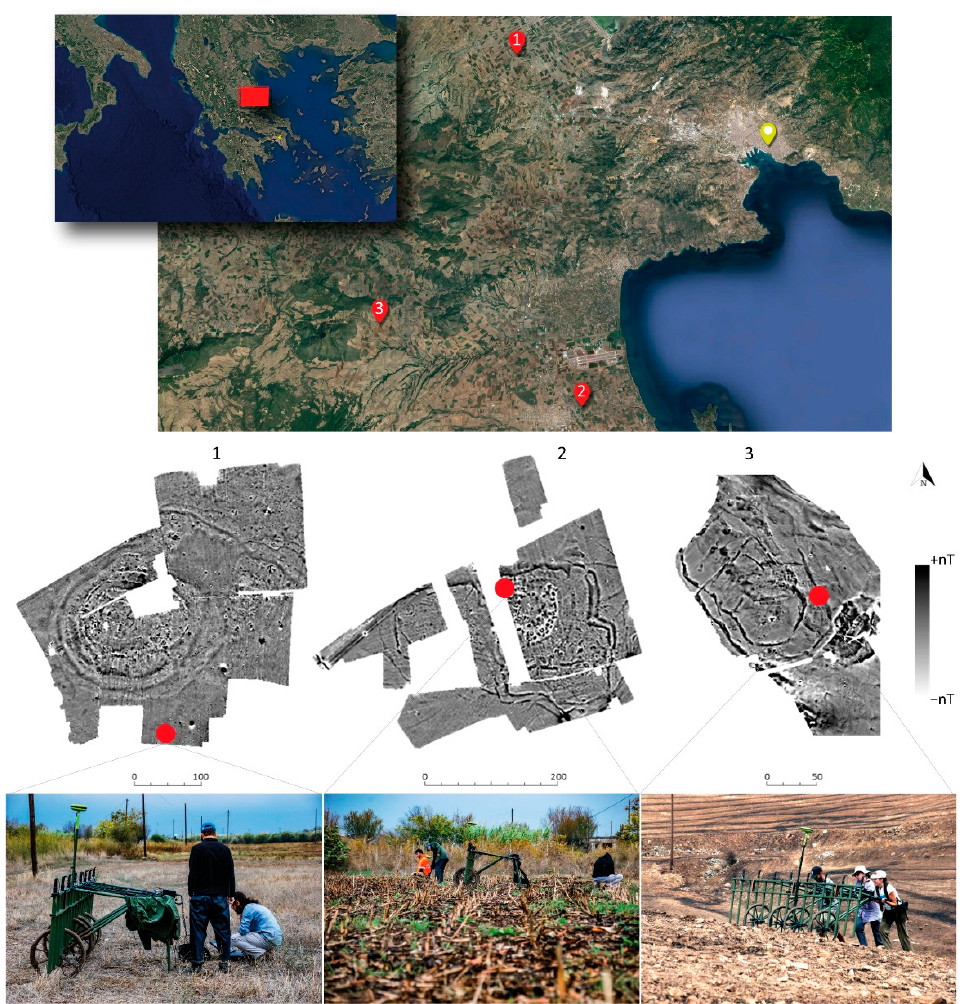
Figure 1. General location of the three case studies in the Thessalian plain ( top ). The red pins mark the location of (1) Rizomilos, (2) Almyriotiki and (3) Perdika II. The yellow pin marks the location of the main city of Thessaly, Volos. Results of the large area magnetometer surveys ( middle ) carried out before the test study reported here. The grayscale image shows positive magnetic anomalies in black and negative anomalies in white. Views of the field during the magnetometer surveys at the three sites ( bottom ). The fields surveyed at Rizomilos and Perdika were fallow. Most of the fields that were surveyed in Almyriotiki were burnt after the crop’s collection (photos credit: Meropi Manataki).